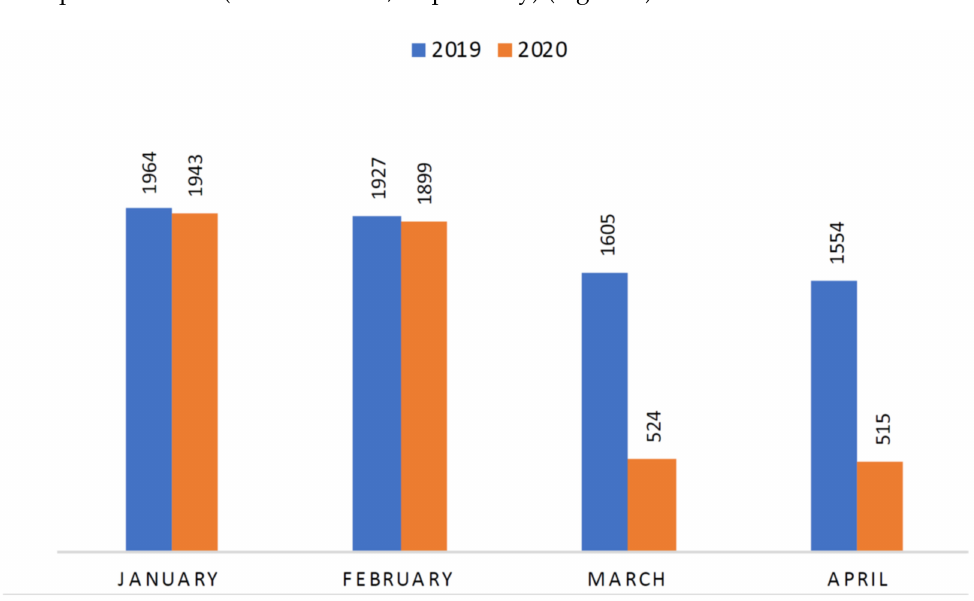
Figure 1. Monthly Pediatric Emergency Department visits from January to April in 2019 and 2020,